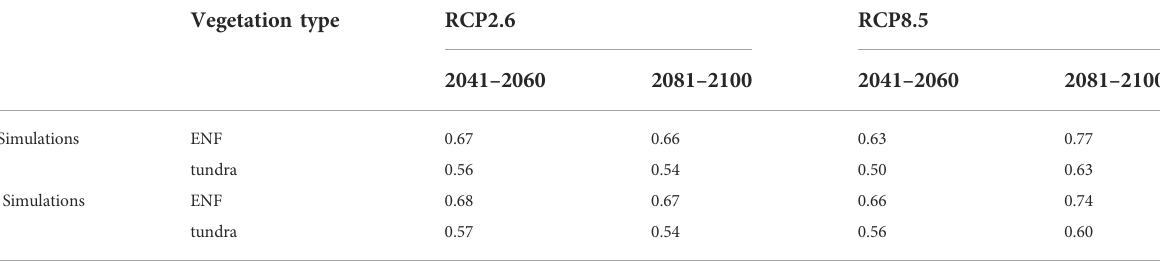
TABLE 2 Spatial correlation coef fi cients of the total ecosystem GPP anomalies with the ENF/tundra GPP anomalies under the in fl uence of extreme heat